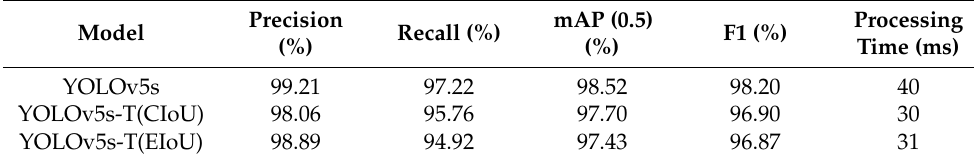
Table 1. Comparison of performance metrics among different models. Model